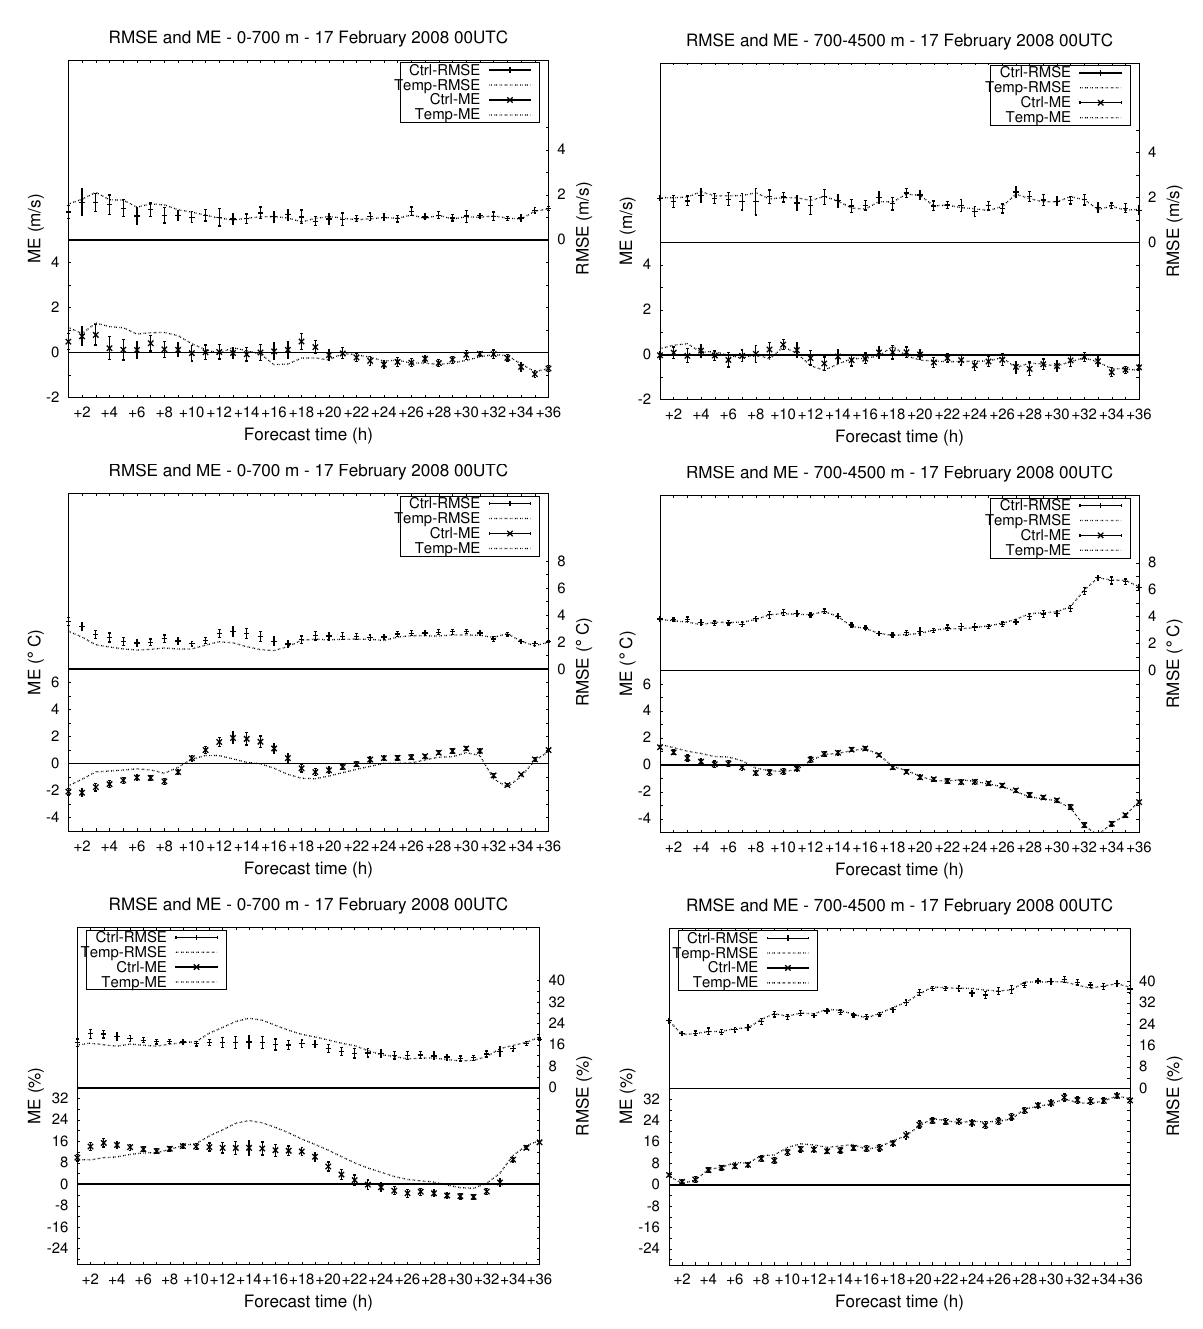
Fig. 9. RMSE and ME for the February 2008 case, over the plains (left) and over the mountains (right); wind intensity (upper panels), temperature (middle panels) and relative humidity (bottom panels). The dots represent the Ctrl run with the significance bar and the dotted line represents the Temp run.